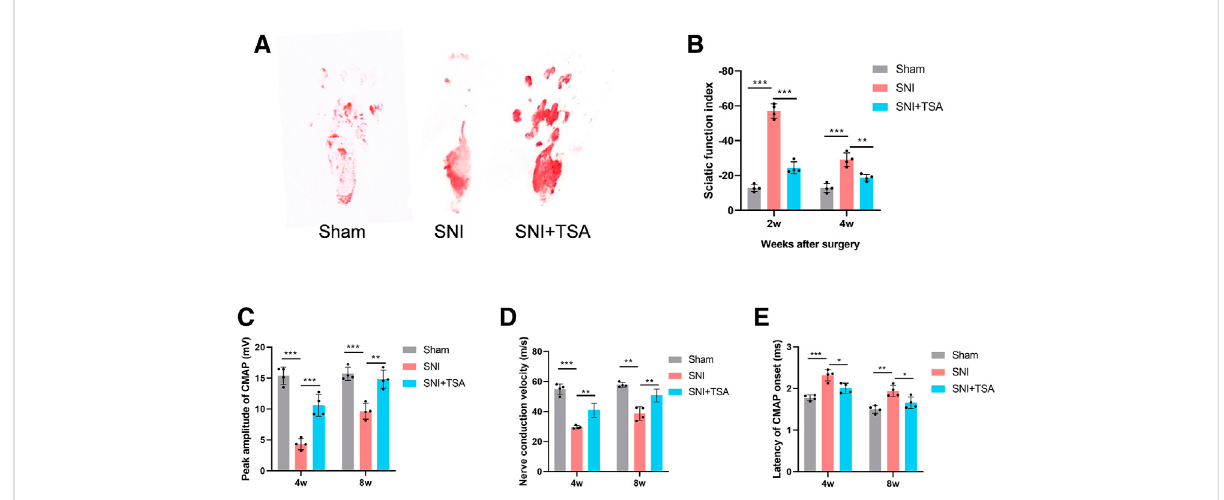
FIGURE 7 Functional evaluation of nerves. (A) Operative footprint images 4 weeks after surgery. (B) The SFI values of each group at 2 and 4 weeks after surgery. (C – E) Peak CMAP amplitude (C) , nerve conduction velocity (D) , and CMAP onset latency (E) 4 and 8 weeks postoperatively. Data are provided as mean ± SD, with n = 4 per group. * p < 0.05, ** p < 0.01, and *** p < 0.001 are deemed signi fi